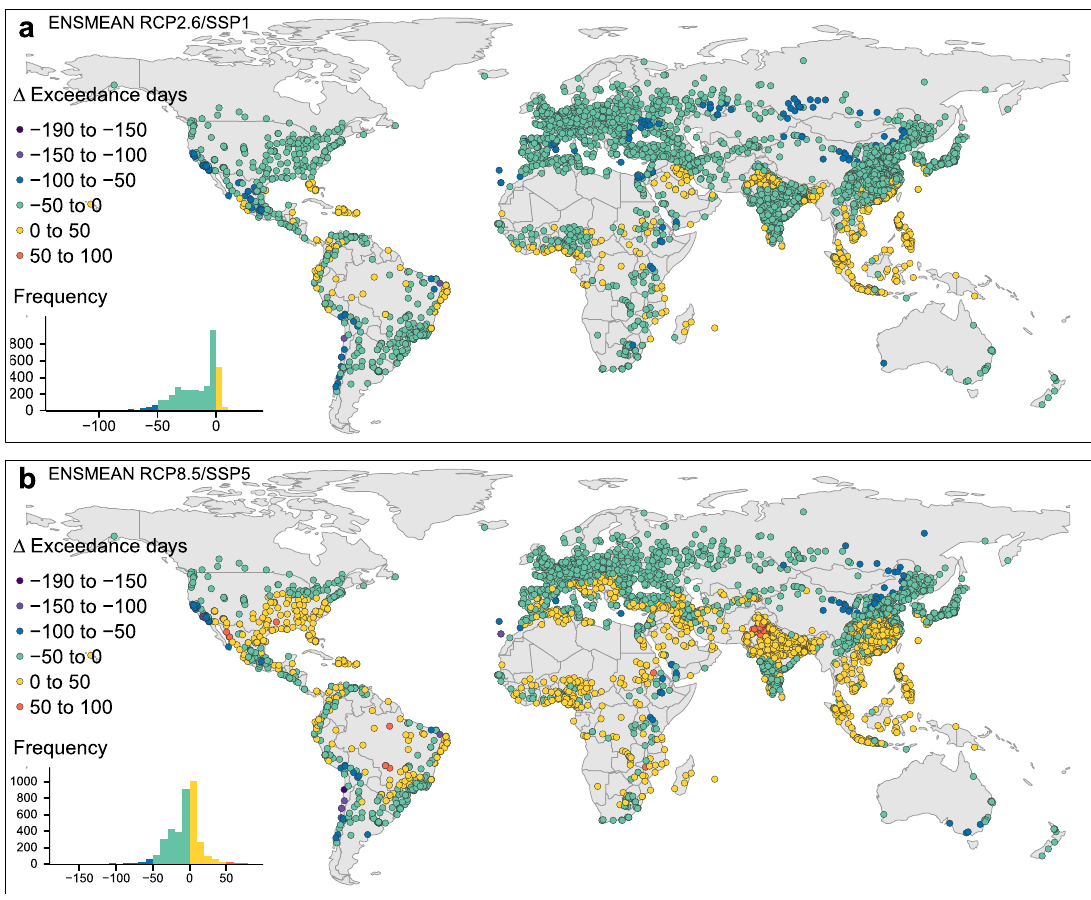
Figure 5. Changes in future heat exposure frequency in major cities worldwide until 2100. (cid:31) EXD 1991–2000 to 2090–2099 in case of RCP2.6/SSP1 ( a ) and in case of RCP8.5/SSP5 ( b ). (Map created in R (version 3.6.2) 28 using the tmap package (version 2.3-2) 29